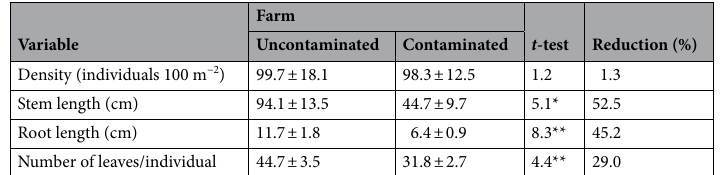
Table 2. Growth characteristics (Mean ± SD) of the eggplants ( N = 60) grown in contaminated and uncontaminated farms. *p < 0.05, **: p < 0.01.